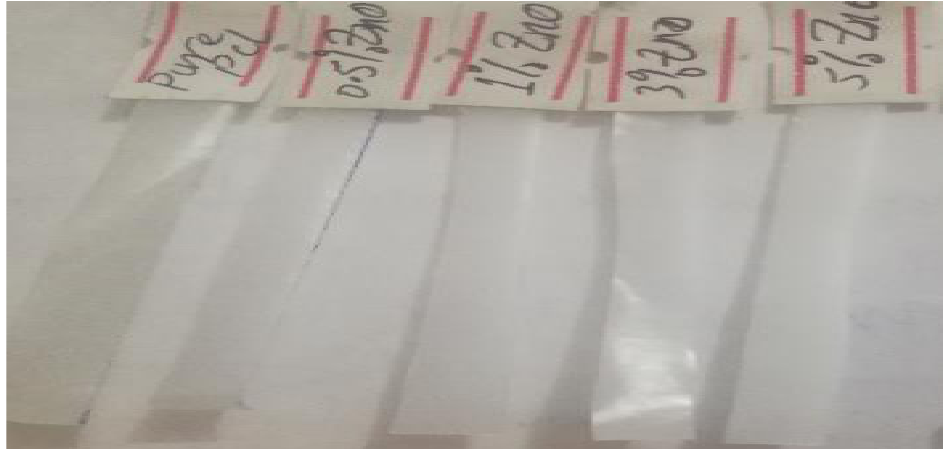
Fig.2: Samples PCL, PCL/ZnO nanocomposites samples test